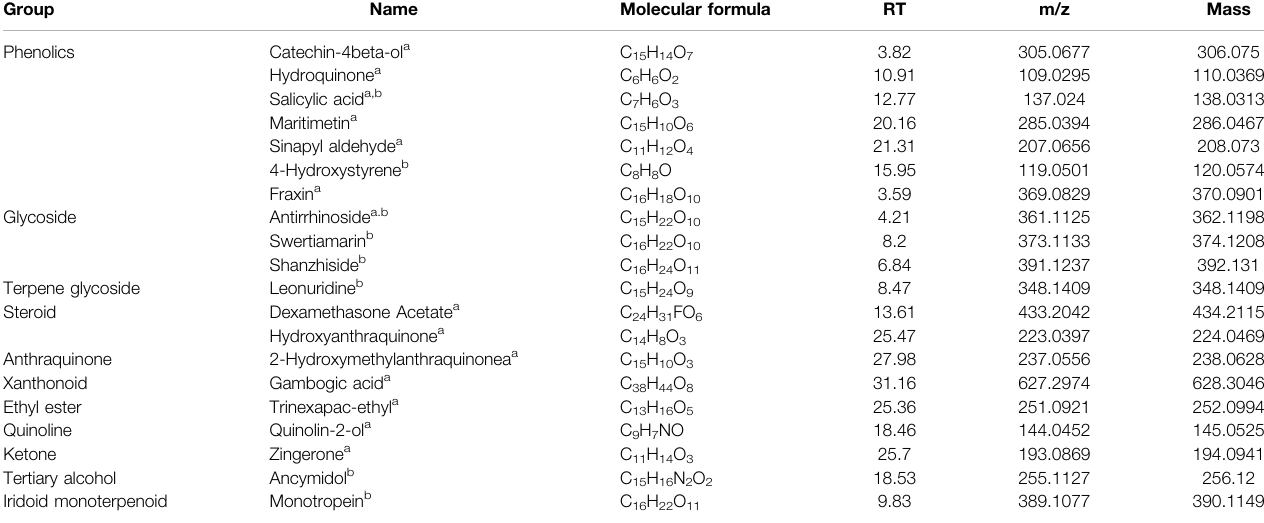
TABLE 4 | Compounds detected from the leaf extracts of B. terminalis and C. grandi fl orus by LC-MS. Group